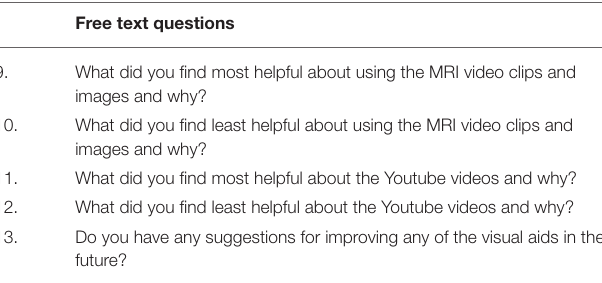
TABLE 3 | Description of the free text questions from the evaluation of visual